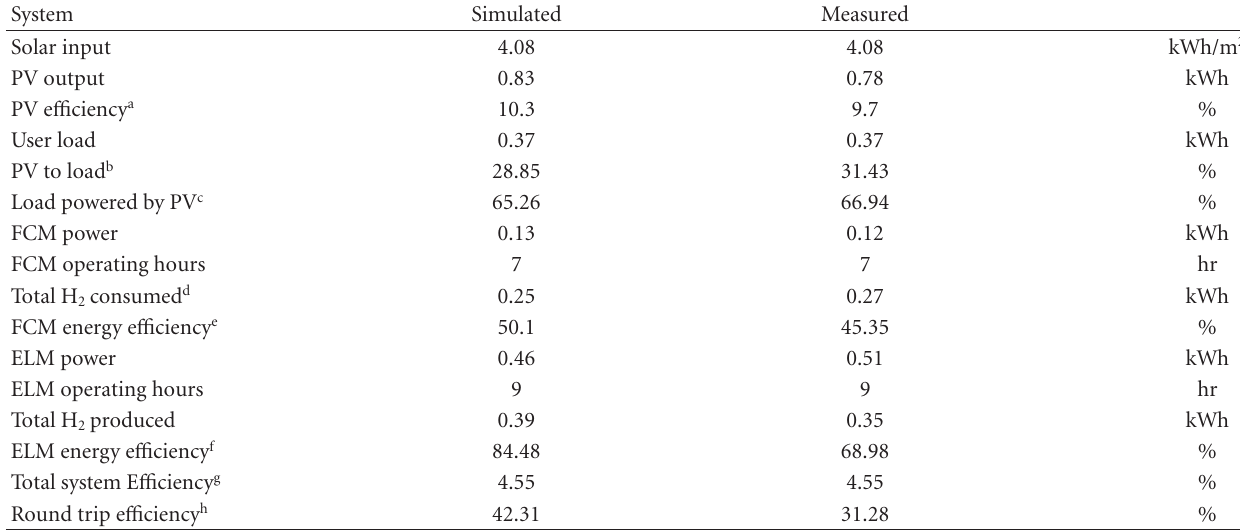
Table 3: Summary of the selected day measured and simulation results.